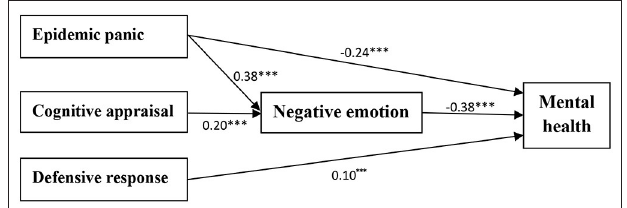
FIGURE 2 | Relationship between epidemic stress response, negative emotion, and mental health. *** p < 0.001.